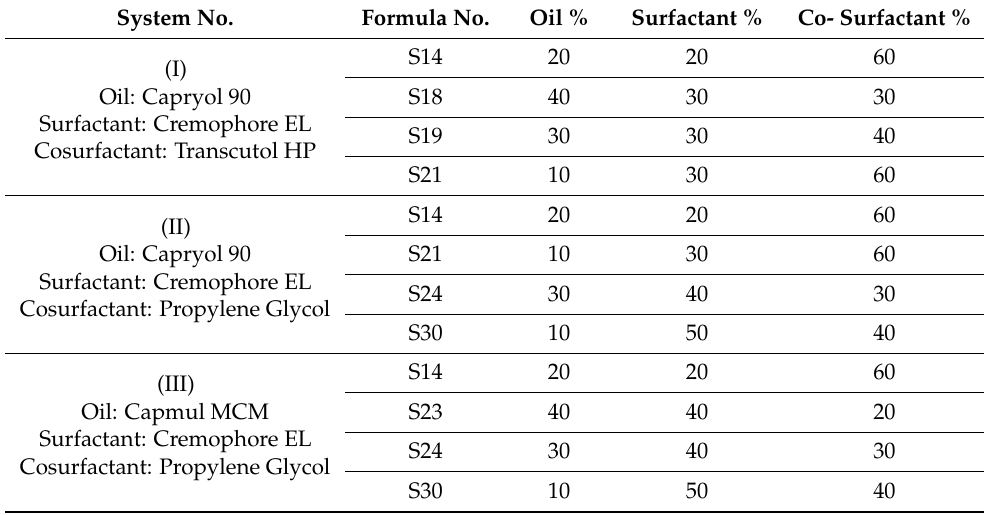
Table 2. The composition of selected liquid self-nanoemulsifying formulations (L-SNEDDS). System No. Formula